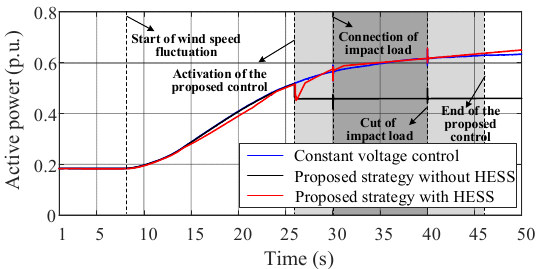
( b ) Figure 16. Real-time LRP and RPCD curves in case I. ( a ) Constant voltage control. ( b ) Active voltage coordinate control with HESS.